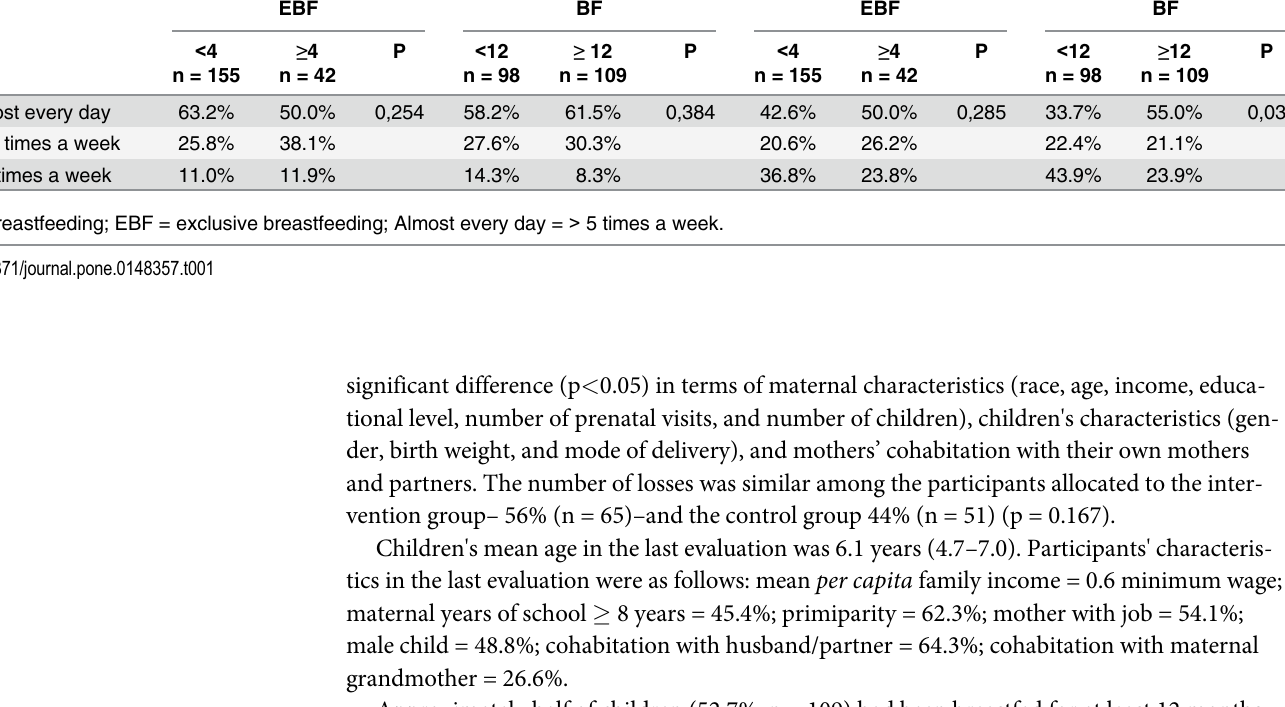
Table 2. Duration of breastfeeding and weekly consumption of fruits and vegetables at 4 – 7 years old.